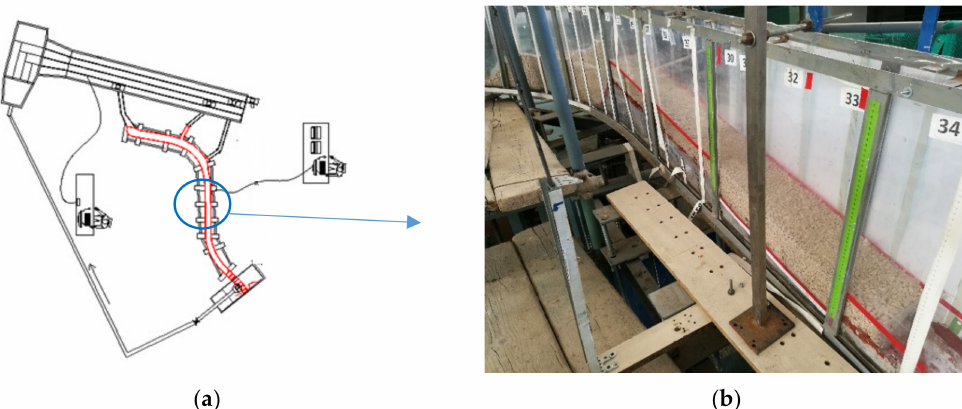
Figure 1. ( a ) Plan view of the experimental apparatus; ( b ) particular of the channel reach considered for the analysis (bed slope = 15 ◦ ; assorted gravels with mean diameter D 50 = 3 mm; the numbers indicate the sections in which the channel was discretized).